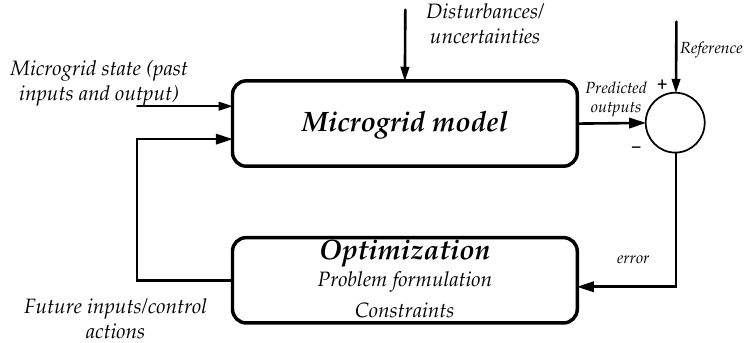
Figure 10. Block diagram of the model’s predictive control